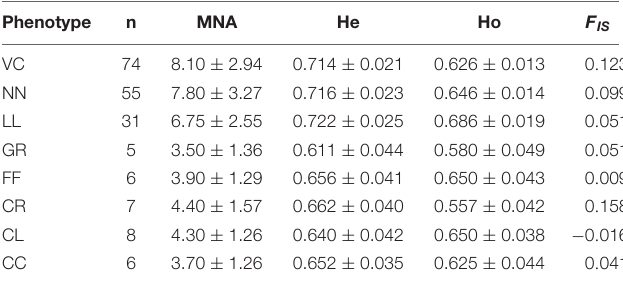
TABLE 4 | Mean number of alleles per locus (MNA), expected heterozygosity (He), observed heterozygosity (Ho), and average inbreeding coefficient ( F IS ) estimated from the 20 microsatellite loci for each